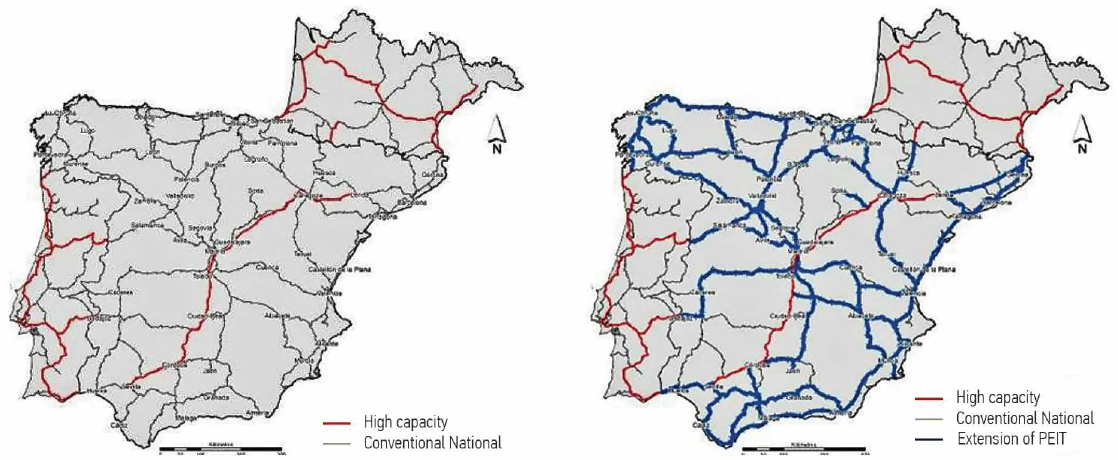
Fig. 2. Rail networks in the reference (2005) and PEIT (2020)